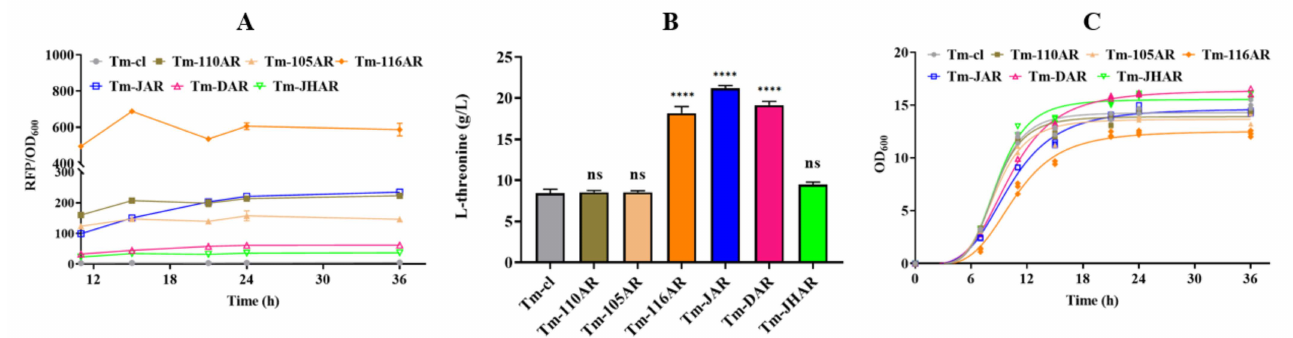
Figure 4. Analysis of the effects of dynamically and constitutively expressed rhtA on L-threonine production. ( A ) Analysis of the expression levels of rhtA during the whole fermentation process.